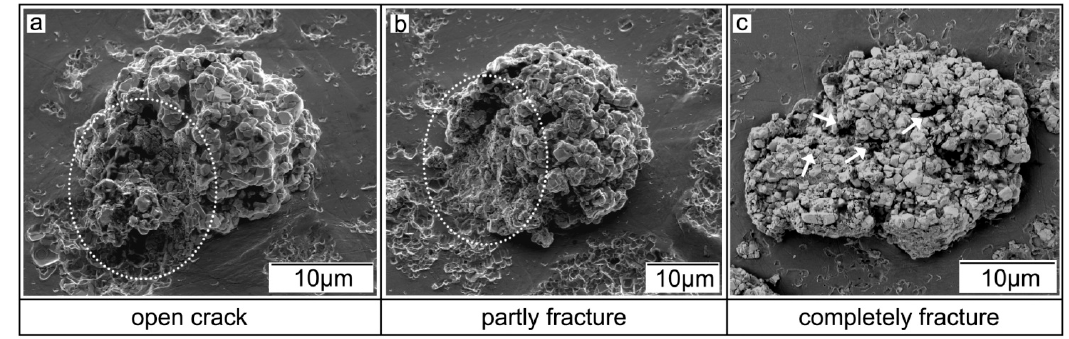
Figure 5. Various fracture modes of WC-Co particles after deposition on SS substrate: ( a ) Open crack, ( b ) partial fracture and ( c ) complete fracture.